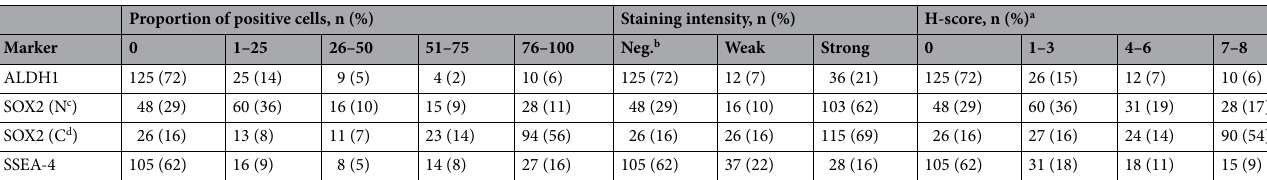
Table 2. Results of immunohistochemical staining from the RC-only cohort. a H-score (0–8) =